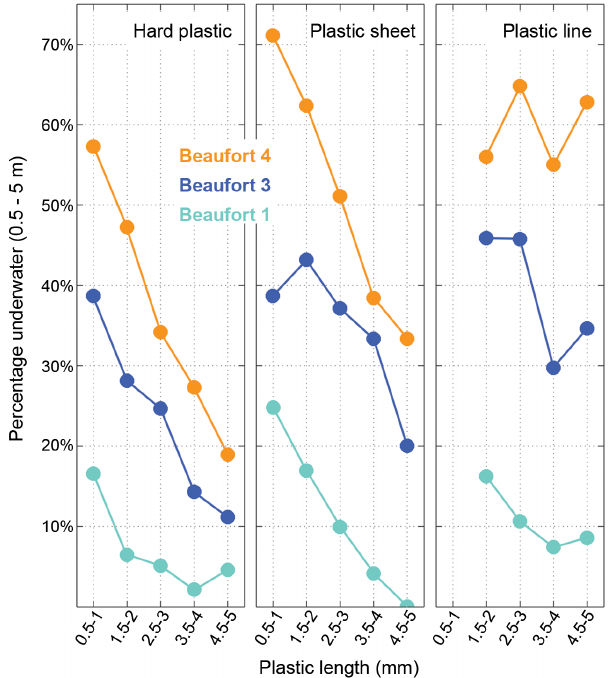
Figure 7. Percentage of plastic pieces of different types and size classes located at depths greater than 0.5m during sampling at Beaufort numbers 1, 3, and